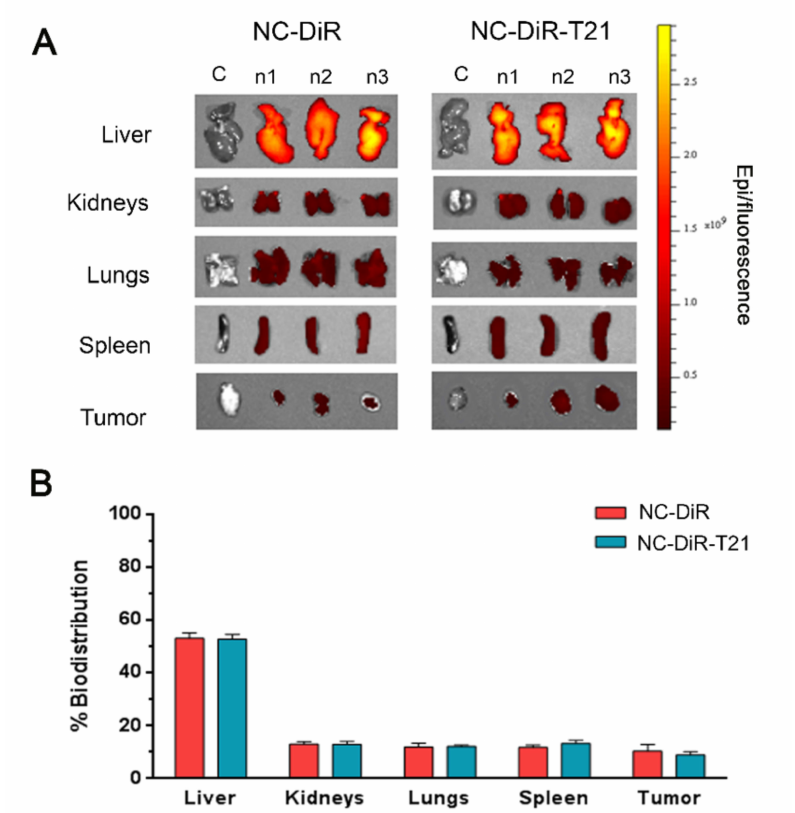
Figure 8. Nanocapsules tissue biodistribution. Mice were administered i.v. with NC-DiR or NC- DiR-T21.Nanoparticle tissue accumulations were determined by ex vivo DiR fluorescence imaging monitoring 72 h post-injection. ( A ) Representative images of the different organs and tumors analyzed. ( B ) Percentage of biodistribution among the indicated tissues after injecting NC-DiR or NC-DiR-T21 nanoparticles. Graph represents the average of total REU/area/tissue ±